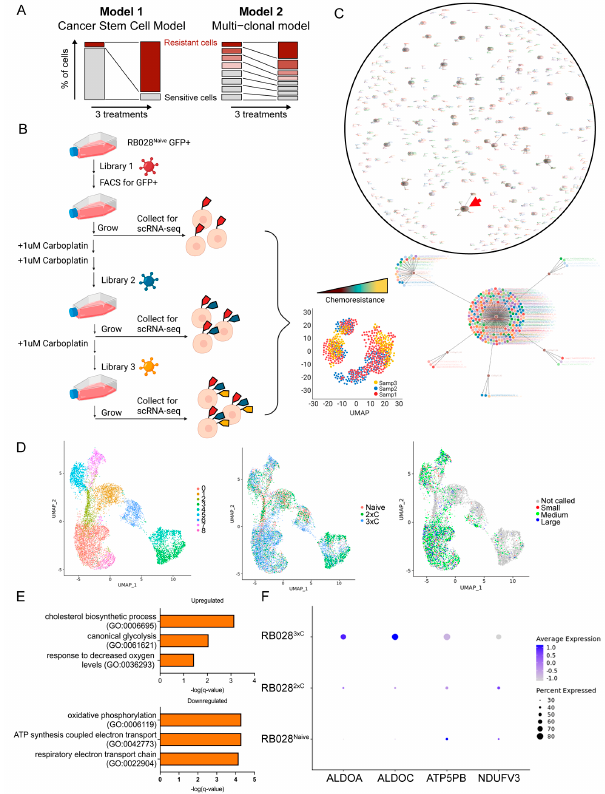
Figure 3. Clonal analysis with barcoded scRNAseq. ( A ) Simplified models of chemoresistance development in retinoblastoma. ( B ) Schematic of clonal analysis experiment. RB028 Naive cells barcoded with CellTag Library #1 were enriched by fluorescence-activated cell sorting (FACS). RB028 Naive were treated twice with 1 μ M carboplatin and transduced with CellTag Library #2 to generate RB028 2xC , which were then treated once more with 1 μ M carboplatin and transduced with CellTag Library #3 to generate RB028 3xC . In total, 10,000 cells of RB028 Naive , RB028 2xC , and RB028 3xC were captured for scRNAseq analysis. ( C ) Reconstruction of lineages between scRNAseq samples with force-directed graphing. Each point represents an individual cell. Each line represents clonal relationships between cells. A total of 2649 cells were assigned to 444 clones. The largest clone with 223 cells (red arrow) is shown enlarged. ( D ) UMAP plot depicting assigned Seurat clusters (left), sample of origin (middle), and clone size (right). ( E ) Gene ontology pathways derived from genes differentially expressed in RB028 3xC compared to RB028 Naive . ( F ) Dot plot of select differentially expressed genes associated with glycolysis and oxidative phosphorylation across RB028 Naive , RB028 2xC, or RB028 3xC cells.